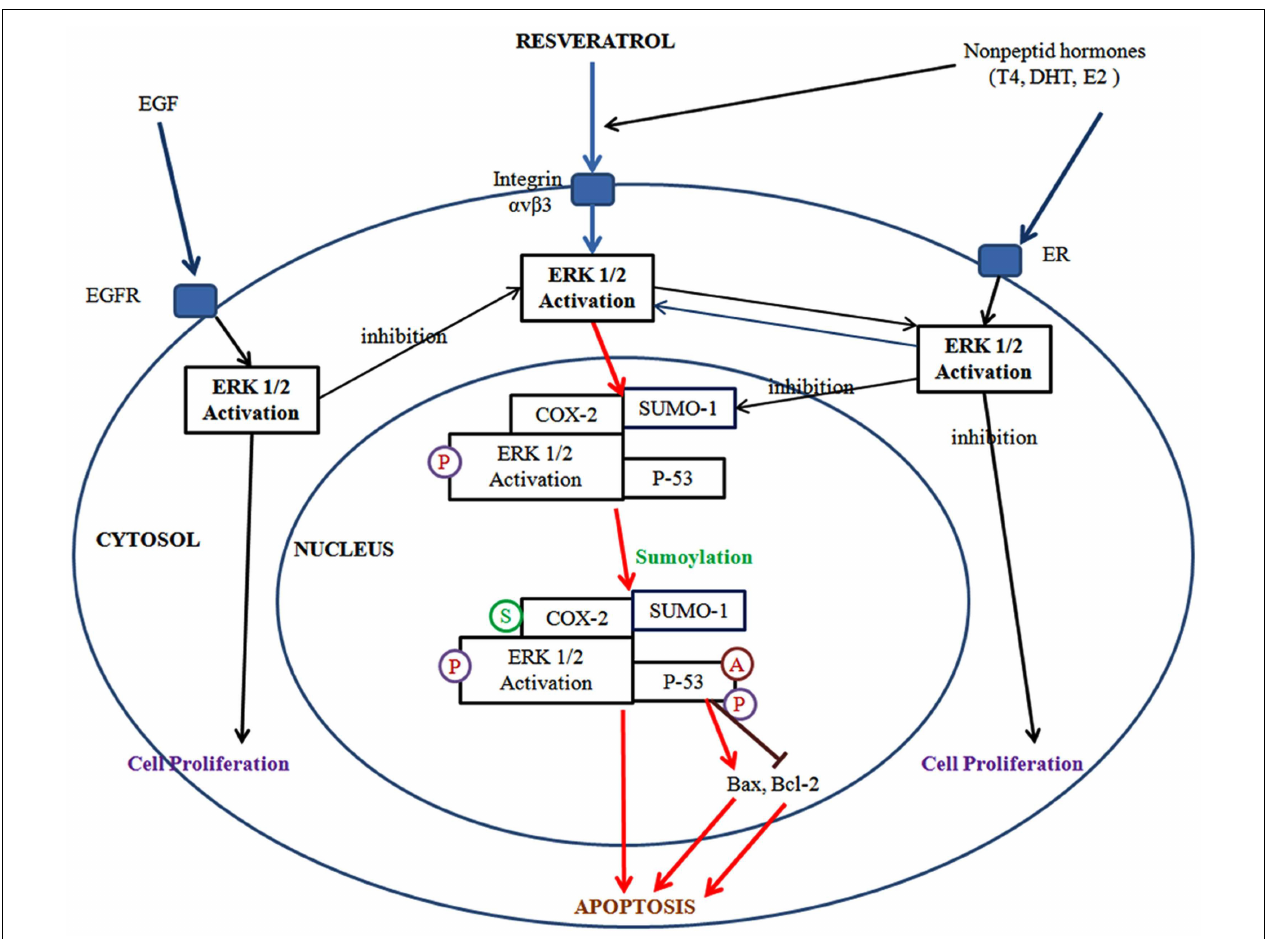
transcription. Activation of ERK1/2 and cell proliferation can be promoted by the binding of thyroid hormone and DHT each other to discrete sites on integrin α v β 3. Estrogen (E2) binds to estrogen receptor (ER) which is the cell surface receptor and integrin α v β 3 may assist in that process. Meanwhile, resveratrol and non-peptide hormone play a distinct role on the activation of ERK1/2 which differs from each other.